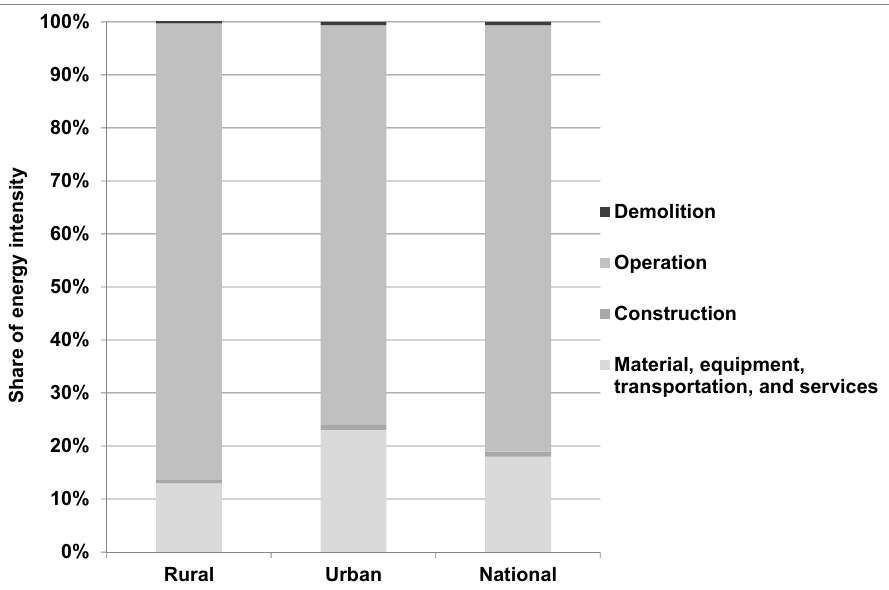
Figure 1. Share of energy intensity over different life stages of residential buildings in China.